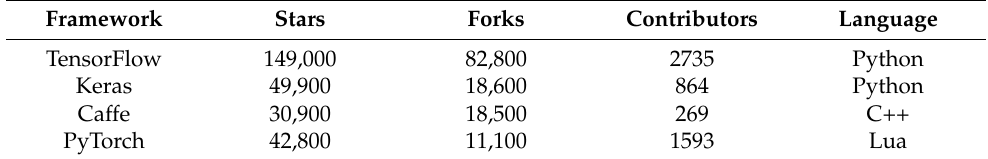
Table 1. Software frameworks ranked by the GitHub community (accessed 28 September